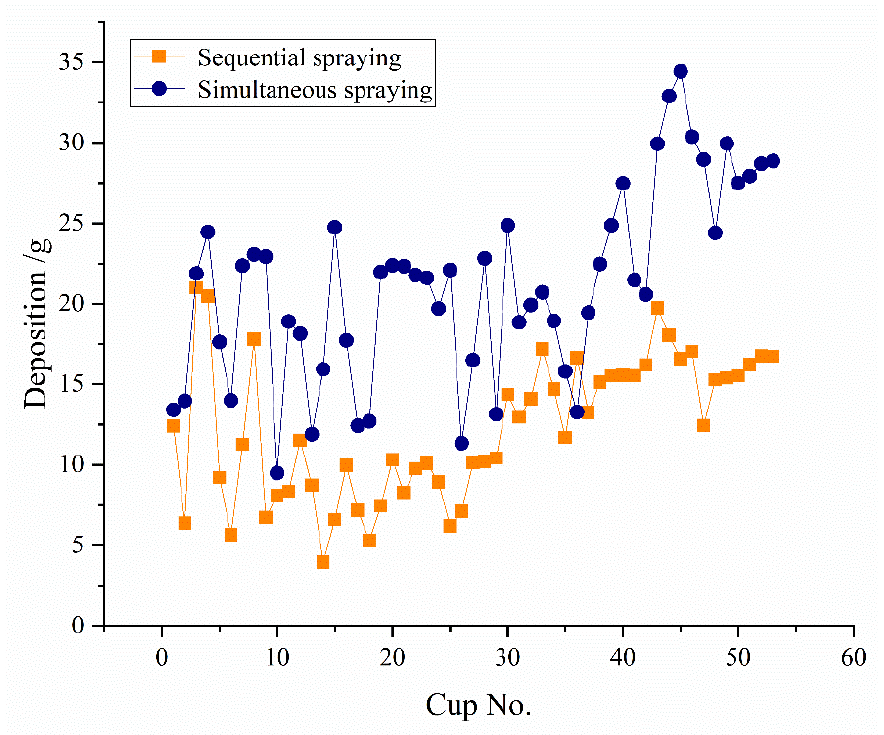
Figure 15. Indoor test results of simultaneous spraying and sequential spraying.